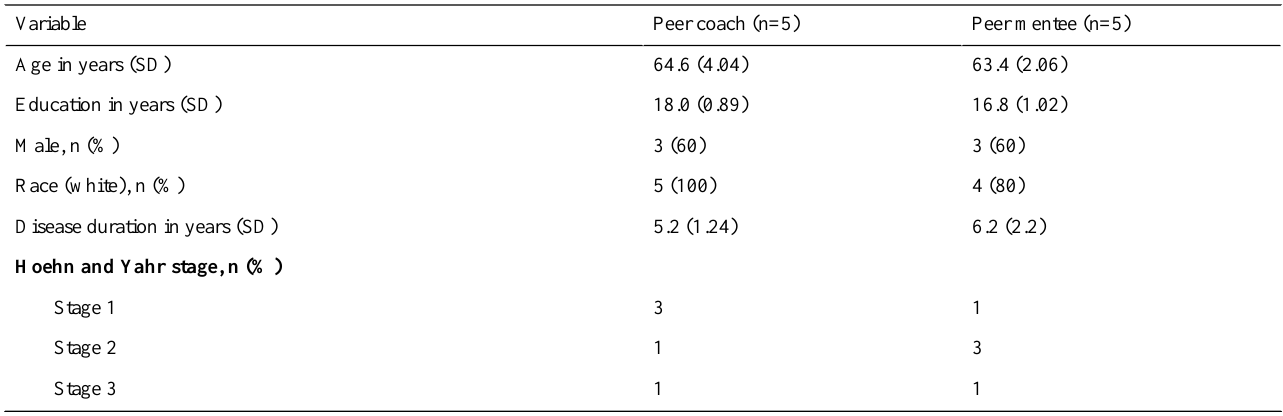
Table 1. Demographics of